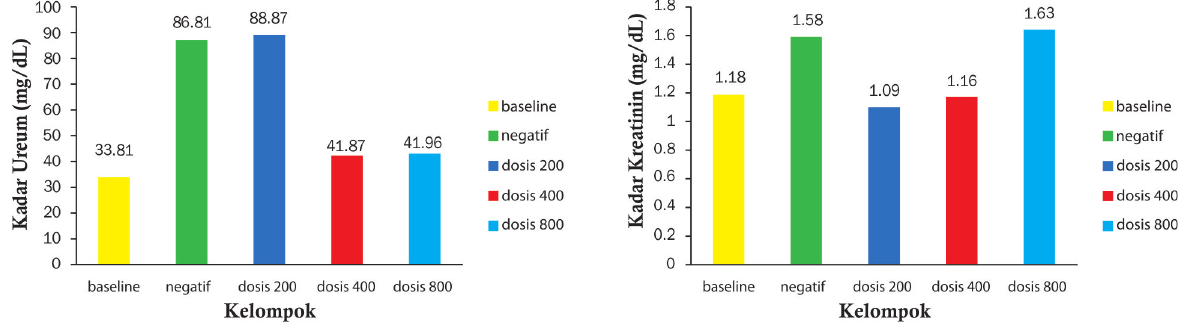
Figure 1. Urea & Creatinine level